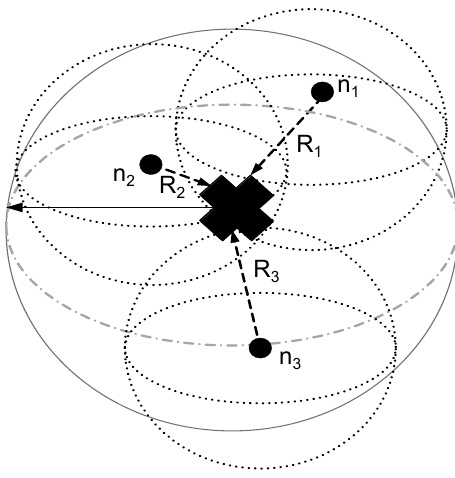
Figure 5. The MS is the neighbor of n i